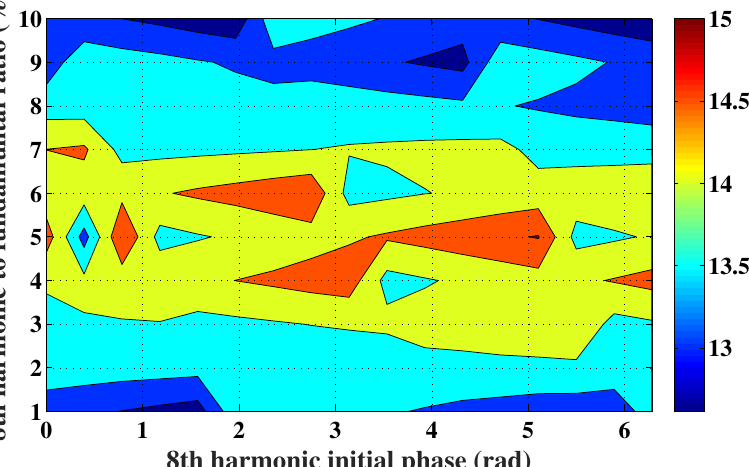
Figure 12. Phases of the dominant harmonics of the spatial repartition of the analytically-predicted flux density versus the rotor position. ( a ) Harmonics of the flux density created by the PMs, ( b ) har- monics of the armature magnetic reaction.